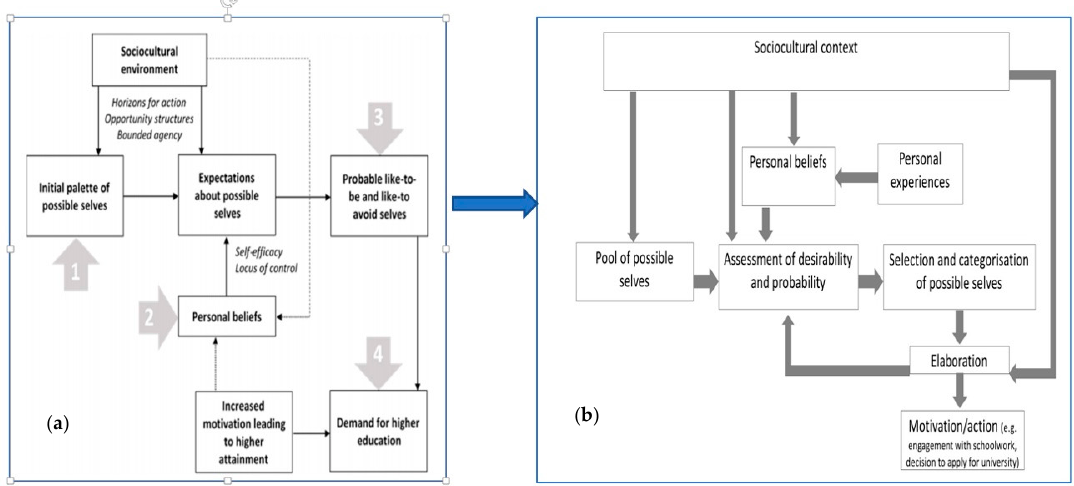
Figure 1. The Possible Selves model as adapted by Harrison ( a ), and our derived model underpinning the present paper ( b ).